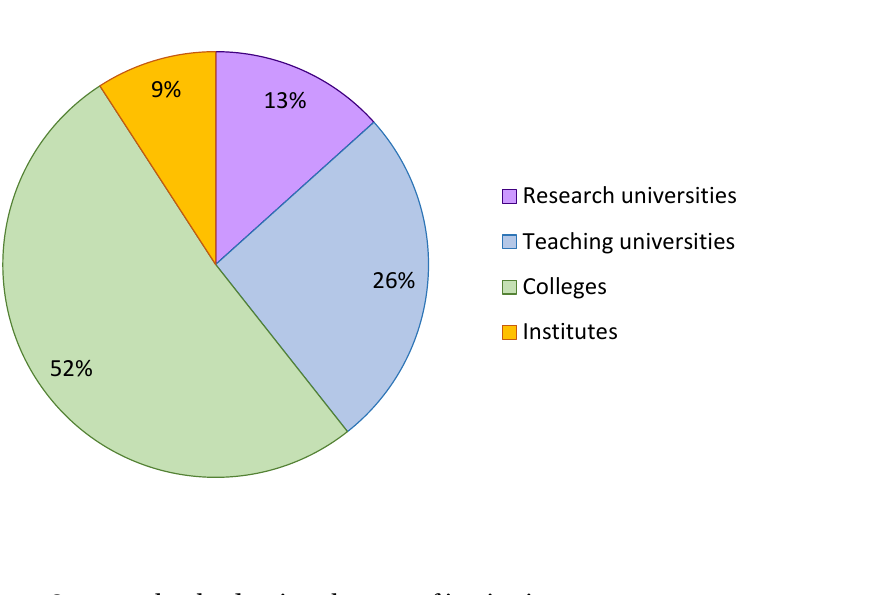
Figure 2. Open textbook adoptions by type of